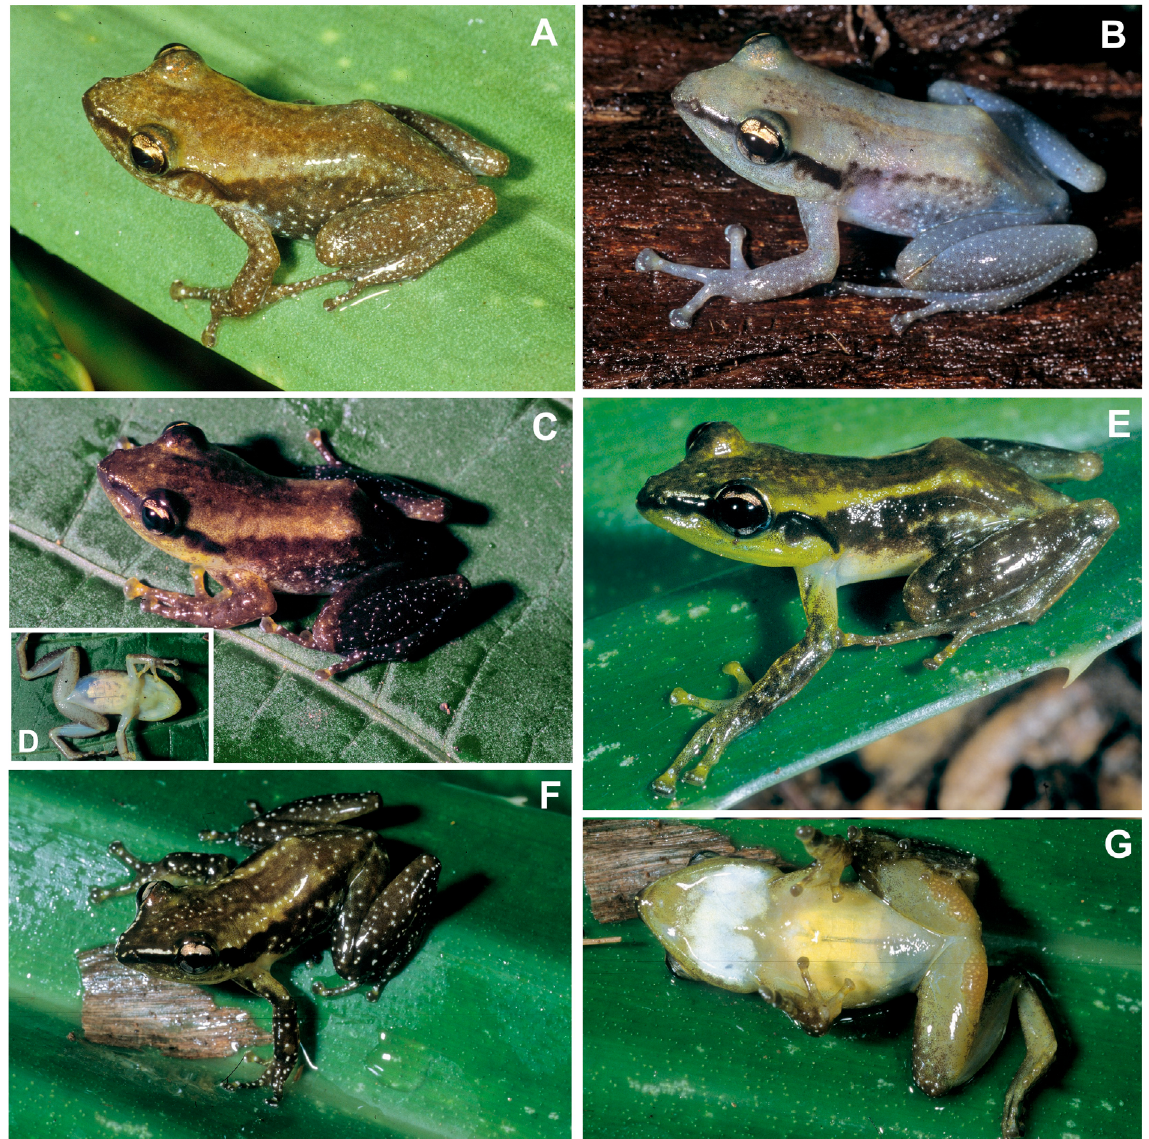
Fig. 4. Guibemantis albomaculatus sp. nov. in life. A–B . Two specimens with unknown sex or voucher numbers from Montagne d’Ambre. C–D . ♀, from Montagne d’Ambre, probably ZSM 894/2003 (FG/ MV 2002.904). e . Specimen from Manongarivo with unknown sex or voucher number. F–G . ♂, from Manongarivo, zSM 816/2003 (FG/MV